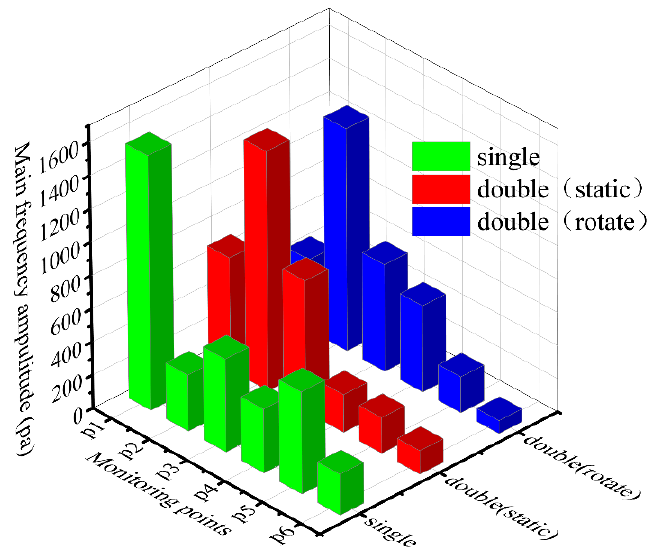
Figure 9. Dominant frequency amplitudes of pressure pulsation for three volutes at different measuring points.